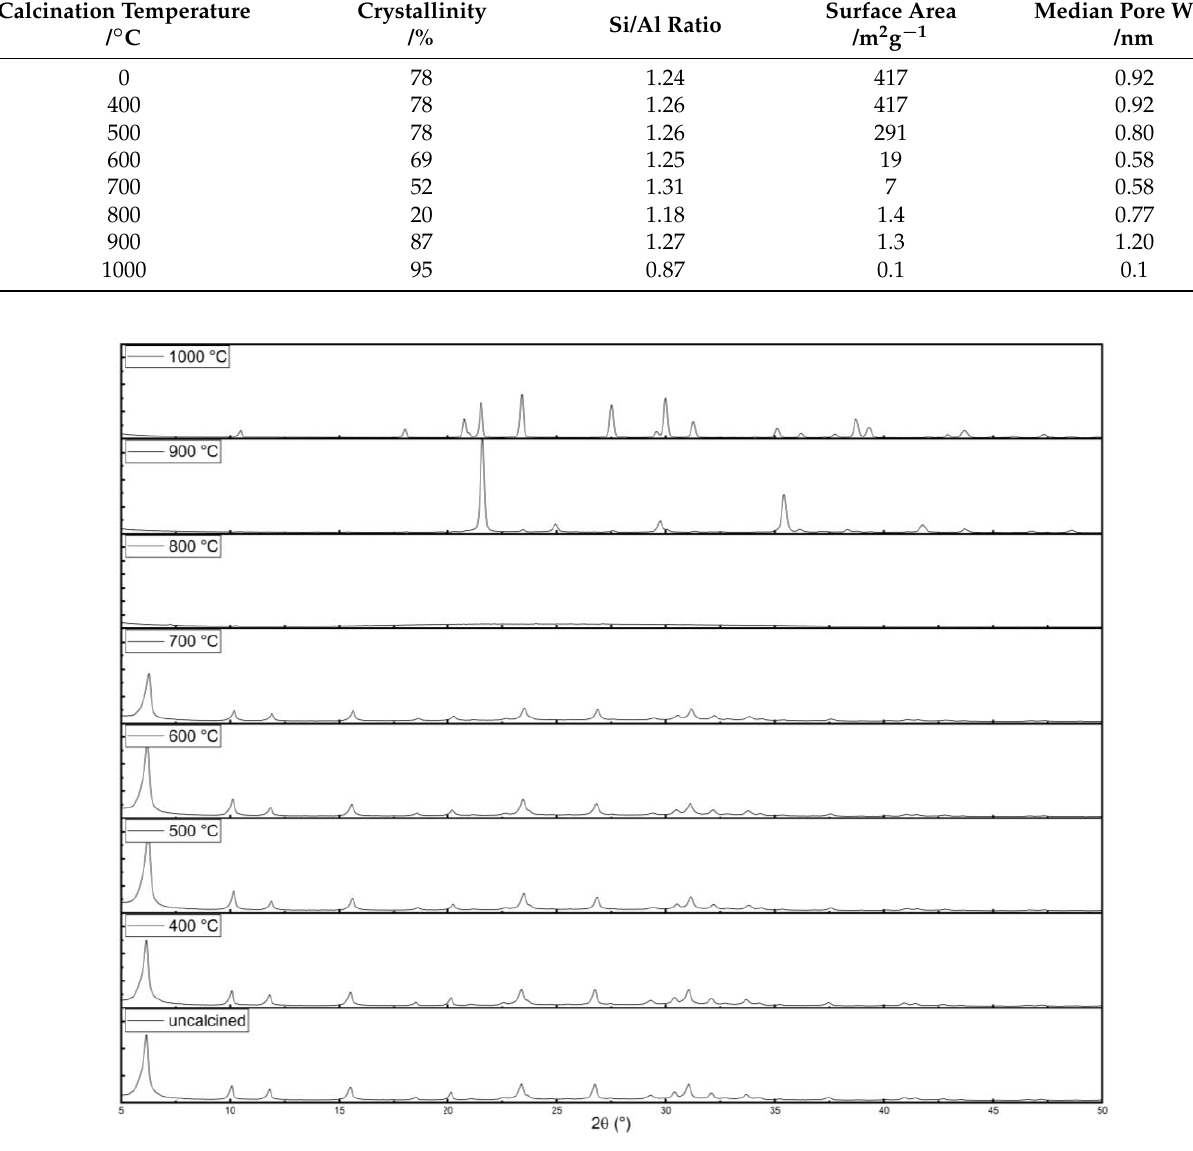
Figure 1: XRPD patterns of LTX zeolite after calcination at different temperatures. Figure 1. XRPD patterns of LTX zeolite after calcination at different Table 1. Crystallinity, Si/Al ratio, surface area, and median pore width of the synthesized LTX catalyst after calcination at different temperatures.